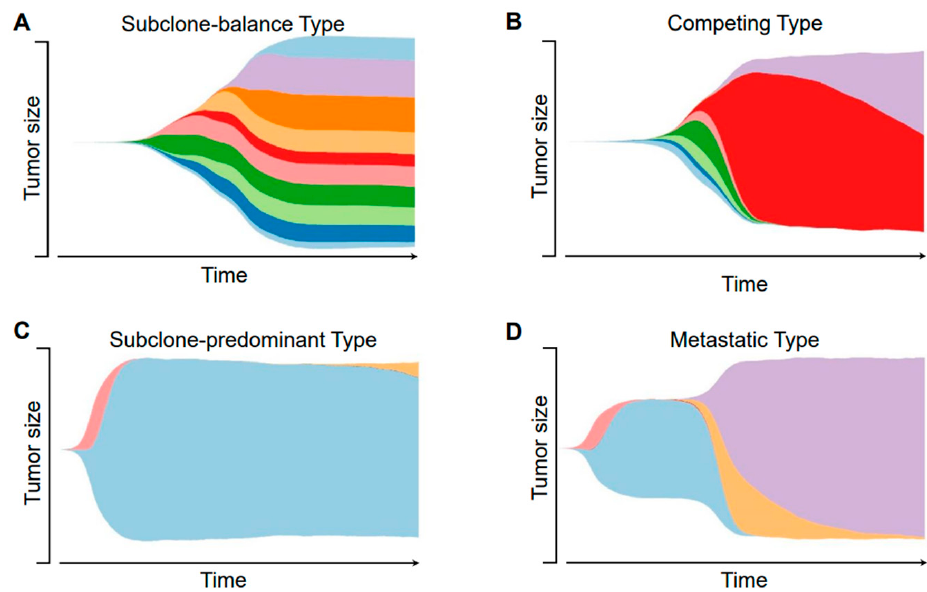
Figure 2. Representative illustrations of the dynamic intra-tumor heterogeneity. This figure shows four examples of the dynamic progression of different tumor subpopulations, each representing a different type. Different colors represent for different subclones, the height of the main body indicates the tumor size. ( A ) The subclone-balance type; ( B ) the competing type; ( C ) the subclone-predominant type; ( D ) the metastatic type.